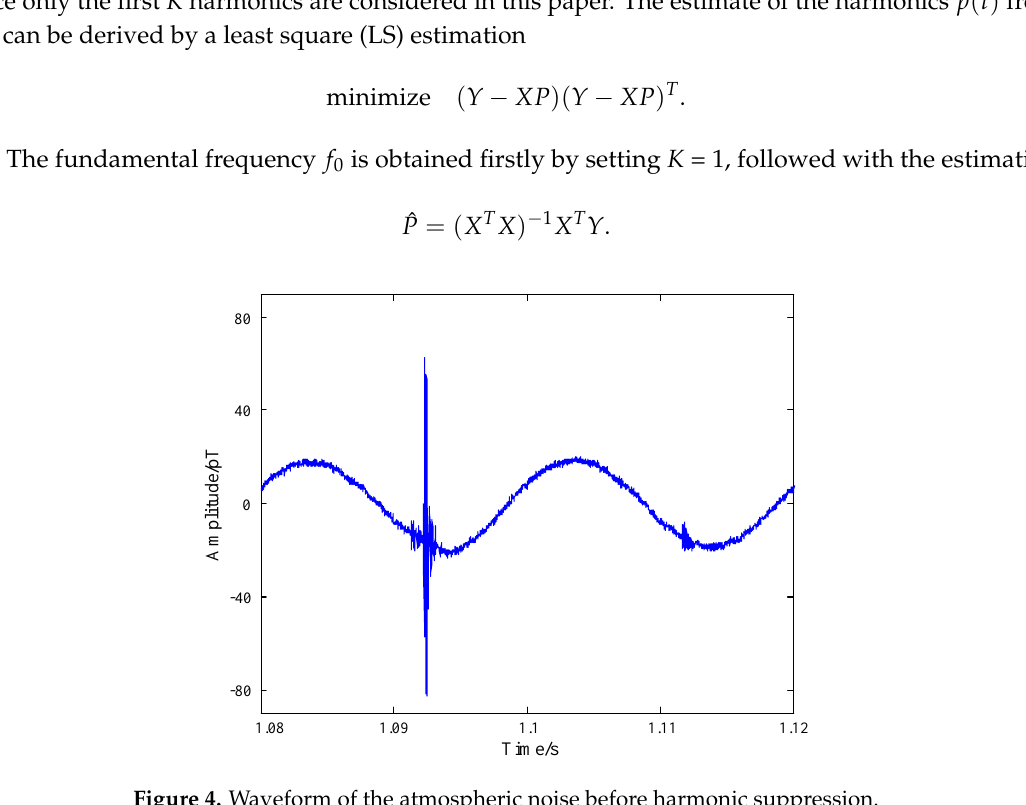
Figure 4. Waveform of the atmospheric noise before harmonic